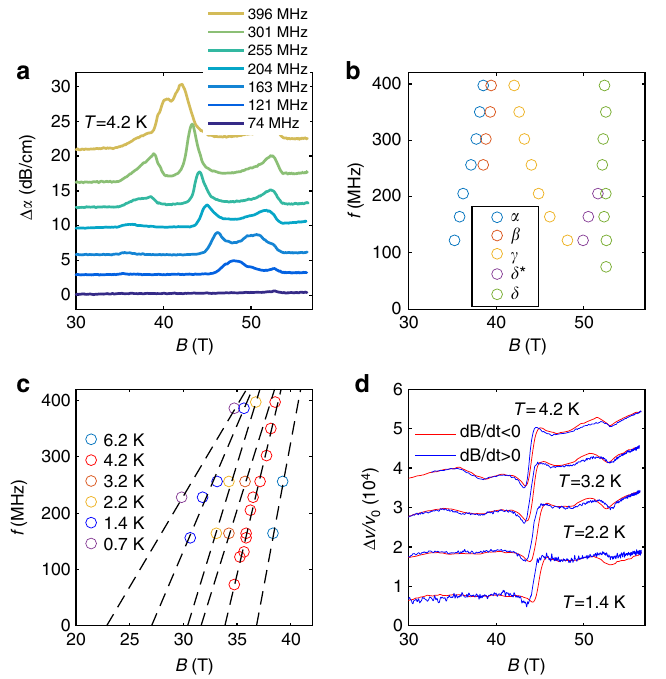
Fig. 5 Frequency dependence of the sound attenuation. a Field dependence of the sound attenuation ( Δ α ) at T = 4.2 K for sound frequencies ranging from 74 to 396 MHz b Frequency — magnetic fi eld phase diagram of the peak position shown in a . c Position of the fi rst attenuation maximum as function of the frequency for temperatures ranging from 6.2 down to 0.7 K. The dashed lines are linear fi ts to Eq. (1). d Sound velocity hysteresis at γ and δ transitions. The red and blue curves correspond to the fi eld-down and fi eld-up sweeps at f = 255 MHz, respectively. No hysteresis is observed for the α and β